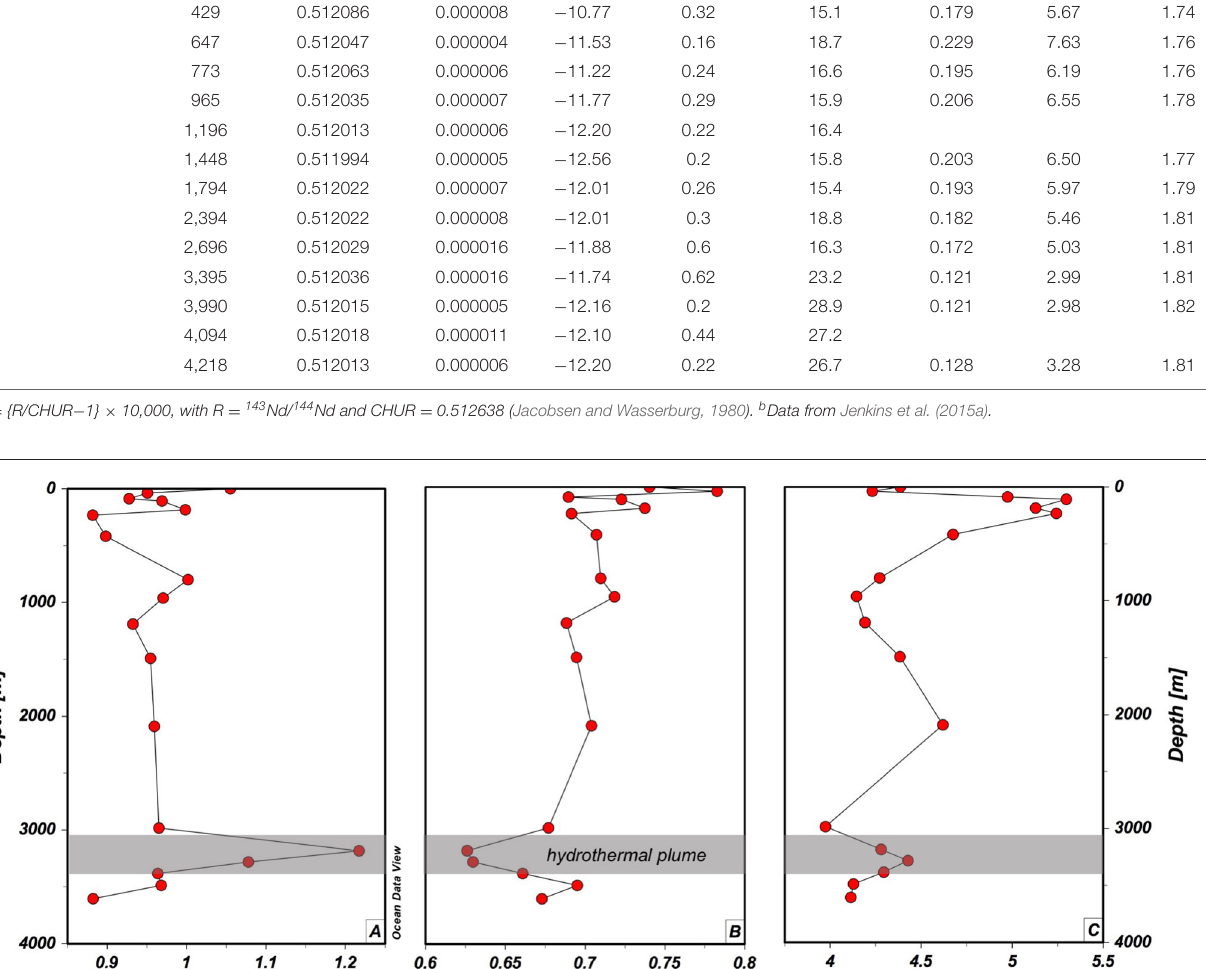
leached out of basaltic plagioclases, and a moderate decrease from 0.704 to 0.626 in the overall homogenous Dy N /Er N at the highest xs 3 He, indicating the influence of hydrothermal activity on REE ( Figure 3